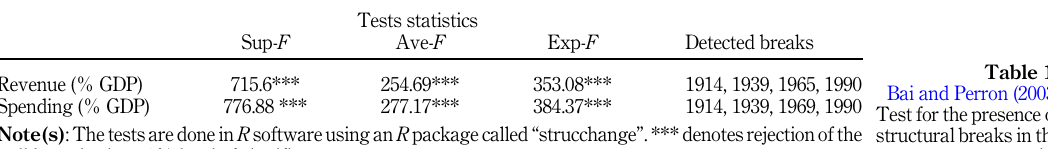
Table 1. Bai and Perron